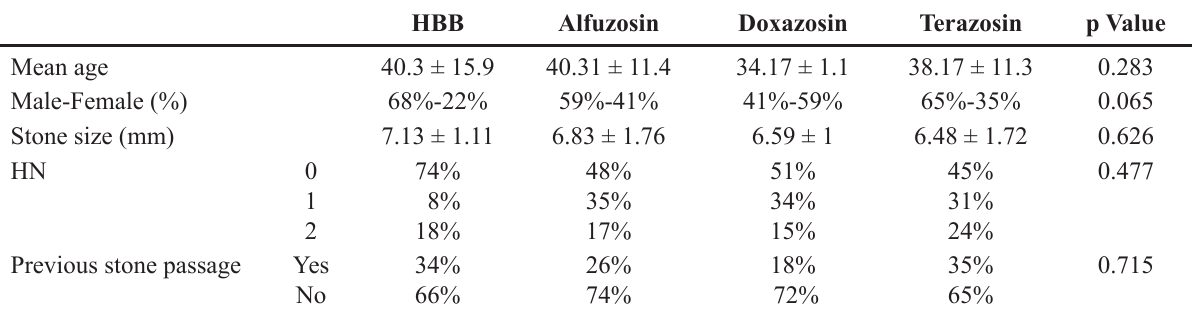
Table 1 – Patients characteristics.